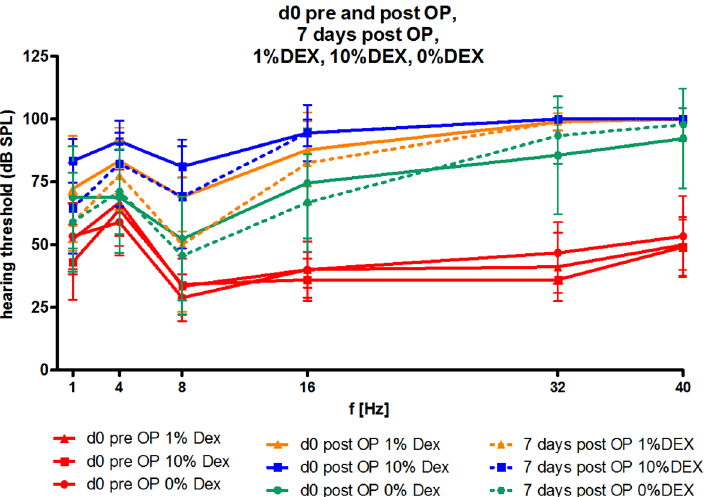
Fig 6. Hearing thresholds on experimental day 0 before and after implantation and on day 7. The mean and SD hearing threshold (dB SPL) in the frequencies tested (1 – 40 kHz) did not differ between groups on experimental day 0 before or after implantation, or on day 7. The hearing threshold in all experimental animals before insertion of the electrode array was equal (red lines). Directly after implantation (straight lines) the hearing threshold increased in all groups and did not change until experimental day 7 (dotted